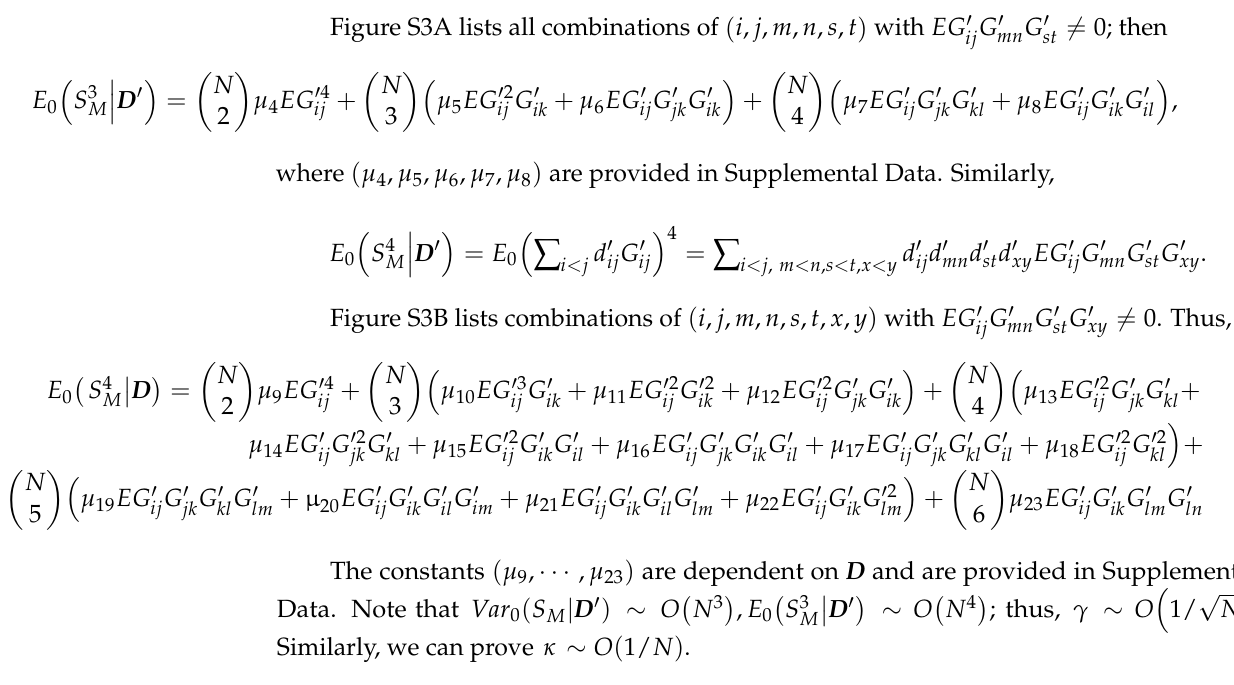
Figure S3B lists combinations of ( i , j , m , n , s , t , x , y ) with EG (cid:48)